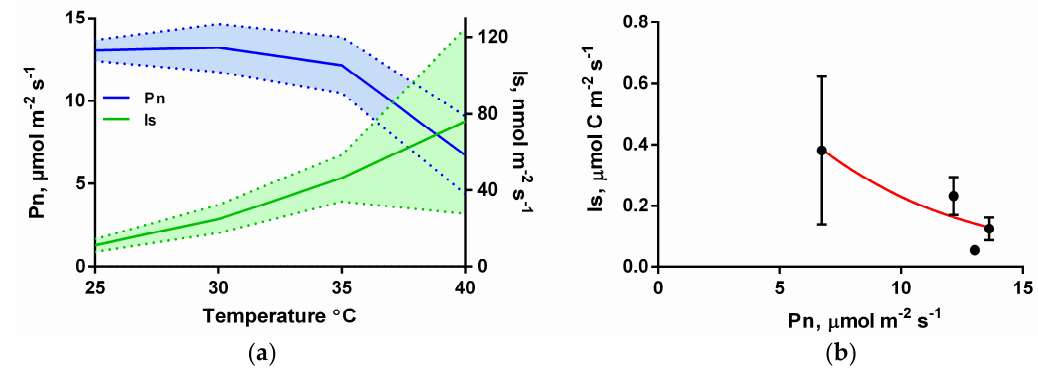
Figure 4. ( a ) Leaf isoprene emissions ( Is , nmol m −2 s −1 ) and net photosynthesis rates ( Pn , µmol m −2 s −1 ) from I. edulis leaves as a function of temperature increases under constant PPFD intensity (1000 µmol m −2 s −1 ) and ambient CO 2 (450 µmol mol −1 ); the solid lines are the averages and the hatching area the standard deviation ( n = 4). ( b ) Isoprene emissions expressed in µmol C m −2 s −1 ( IsC ) against Pn (µmol m −2 s −1 ) as temperature intensity increases in the same conditions; means and standard deviation with n = 4.